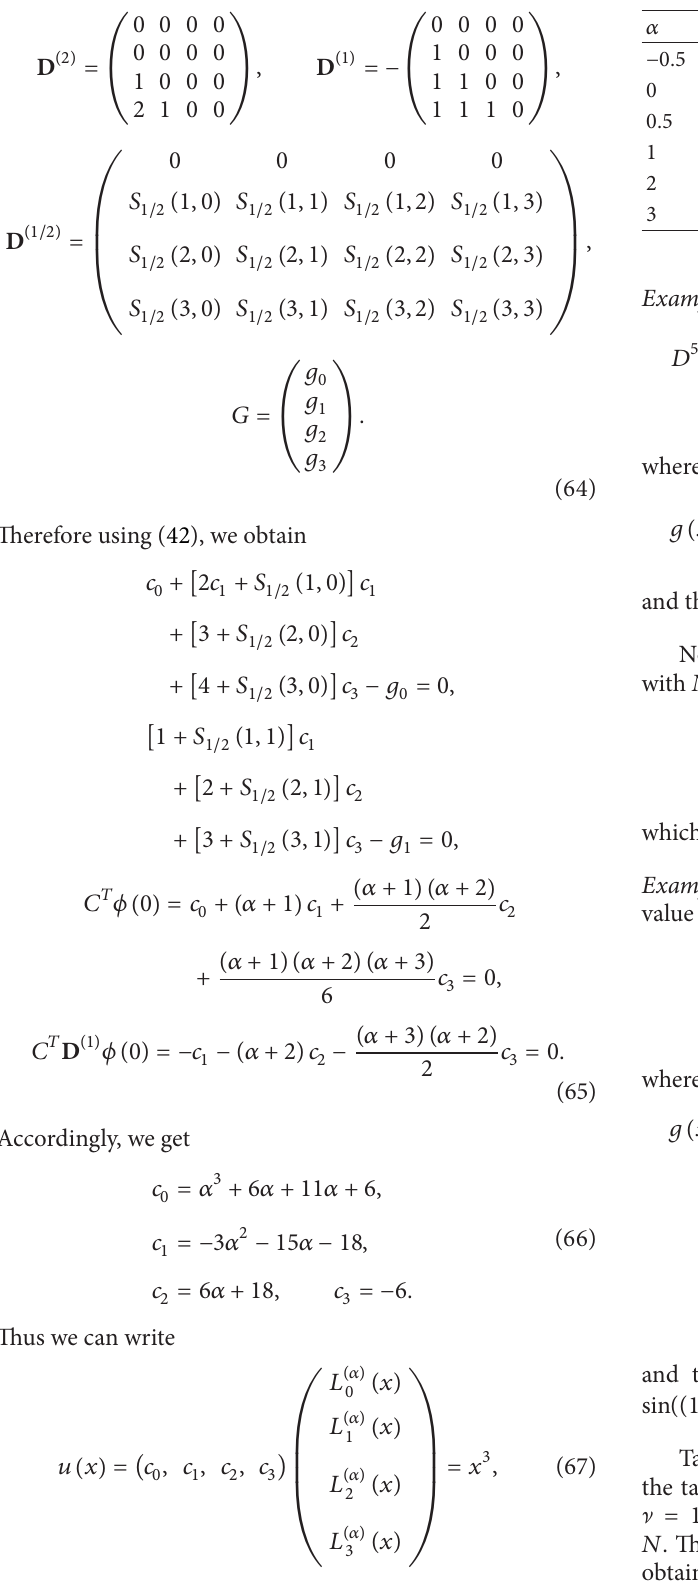
Table 3: 𝑐 0 , 𝑐 1 , 𝑐 2 , and 𝑐 3 for different values of 𝛼 for Example 3.